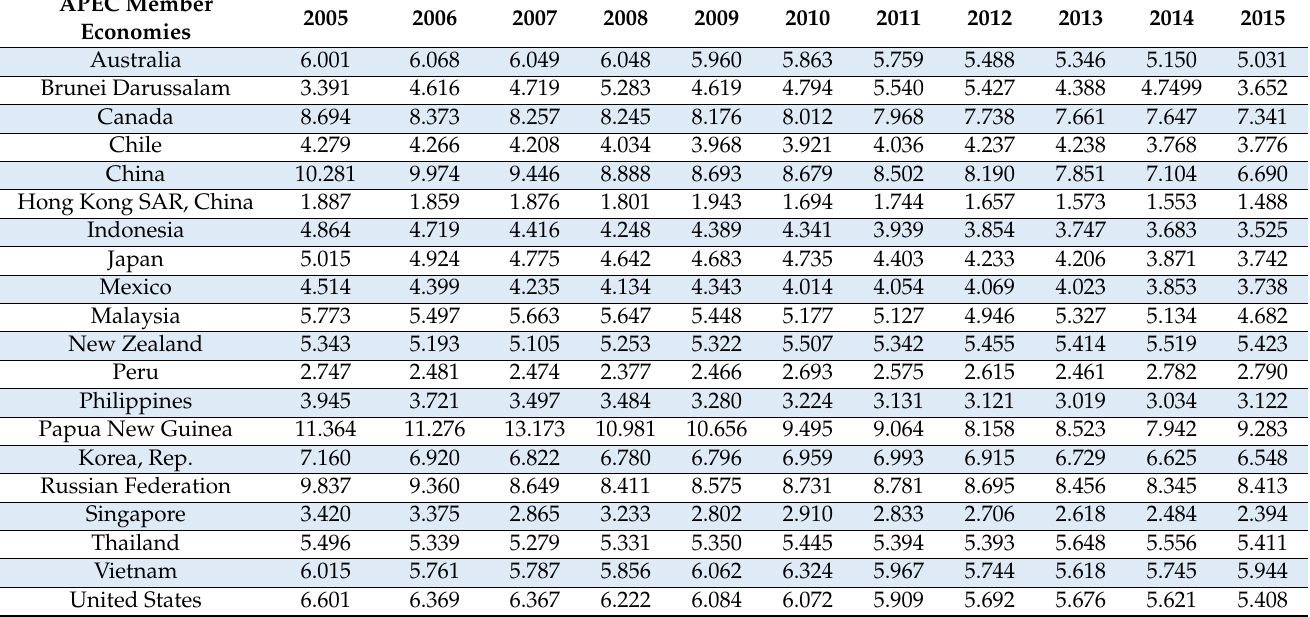
Table A4. Energy intensity level of primary energy (MJ/USD2011 PPP